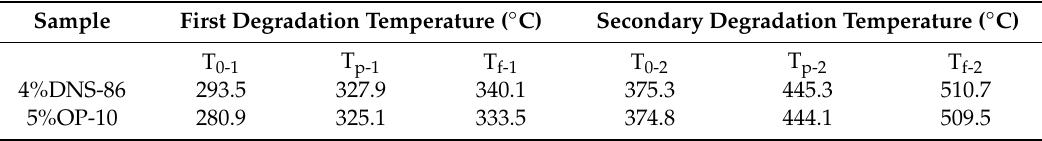
Table 4. Thermal degradation temperature of films.